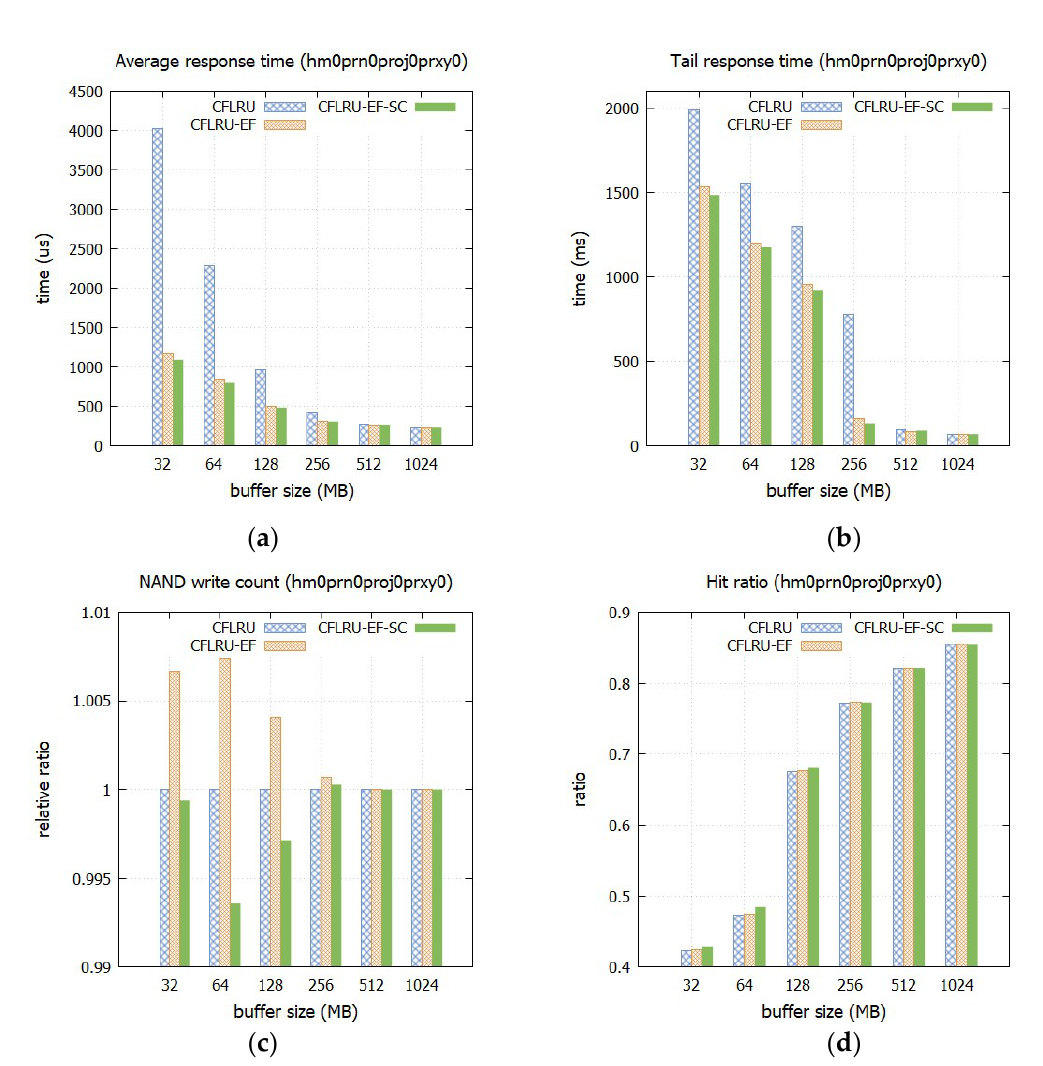
Figure 8. Results with periodic flushing. ( a ) average response time; ( b ) tail response time; ( c ) NAND write count; ( d ) hit ratio.